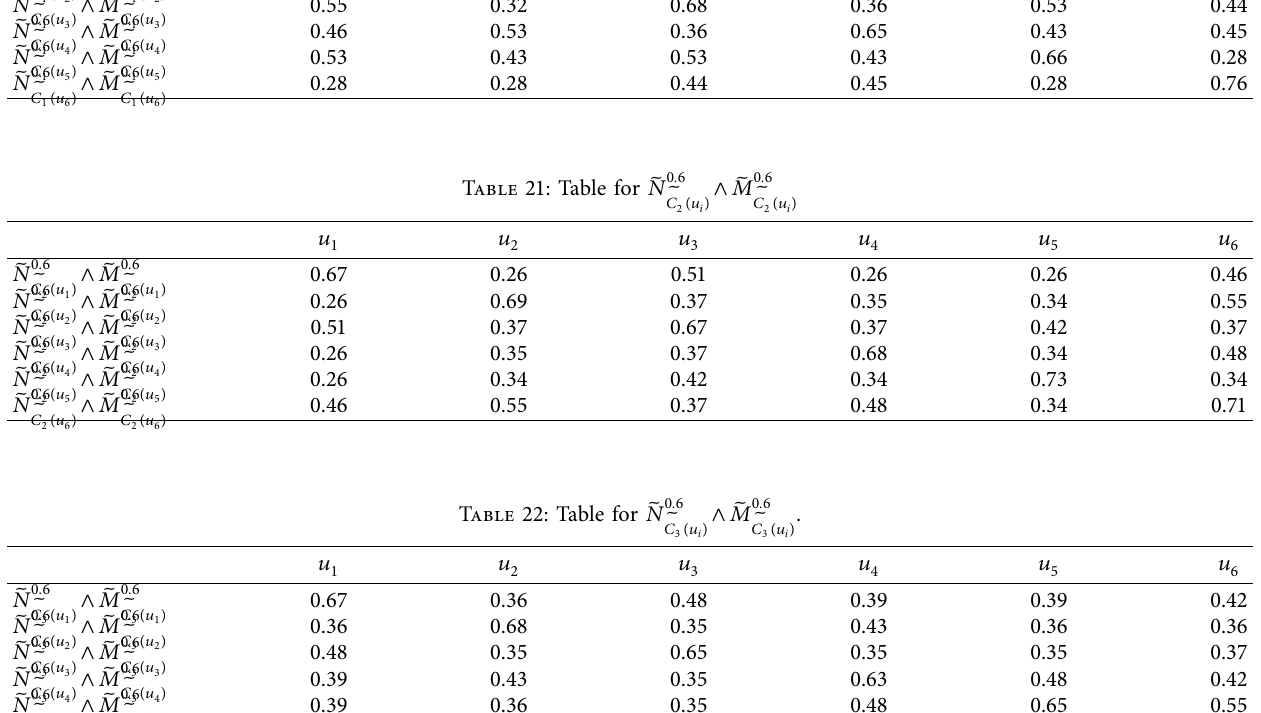
Table 20: Table for 􏽥 N 0 . 6 􏽥